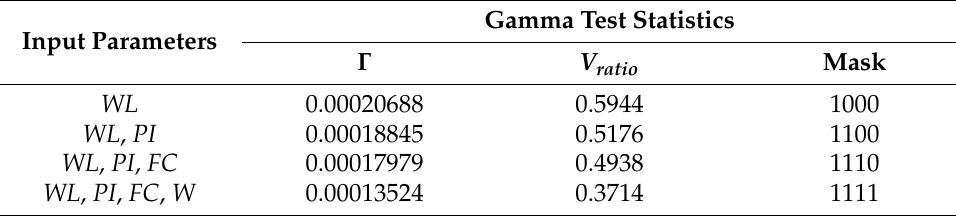
Table 8. GT statistics of different input